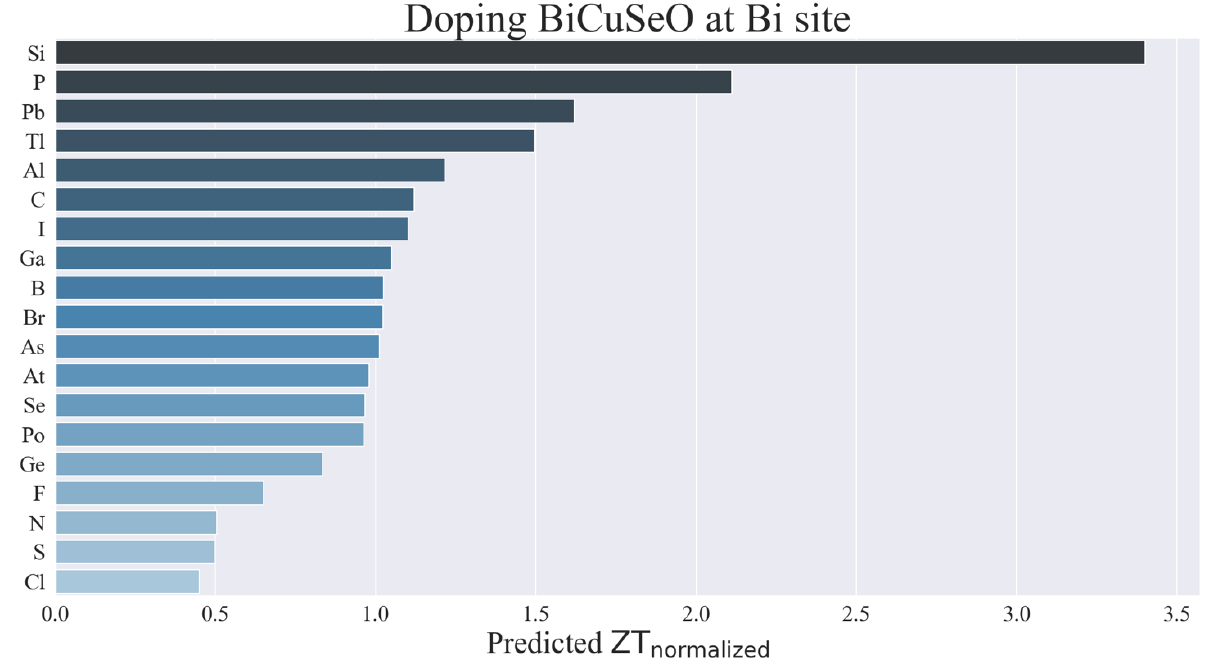
Figure 7. Predicted ZT normalized values for the selected Bi 0.98 A 0.02 CuSeO compounds, where A is the dopant shown in the y -axis.